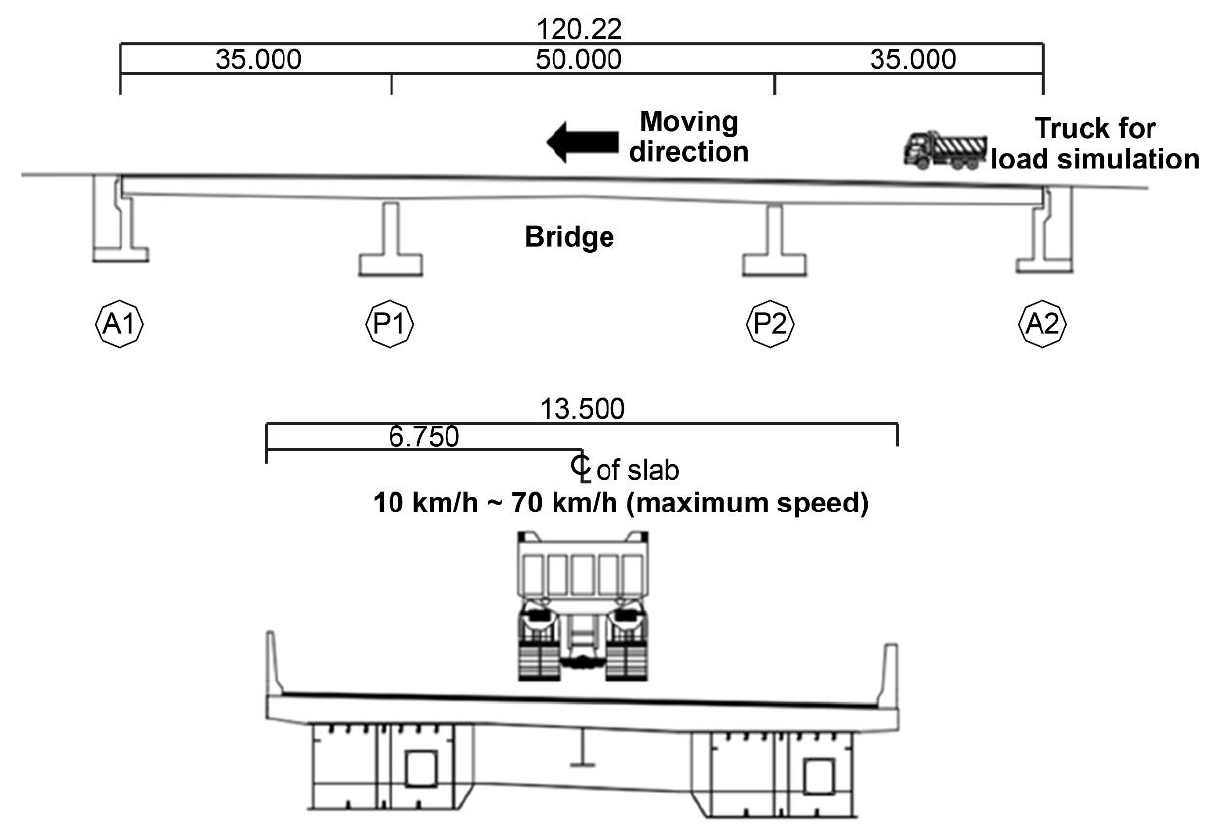
Figure 8. Operation process of the dynamic loading test.